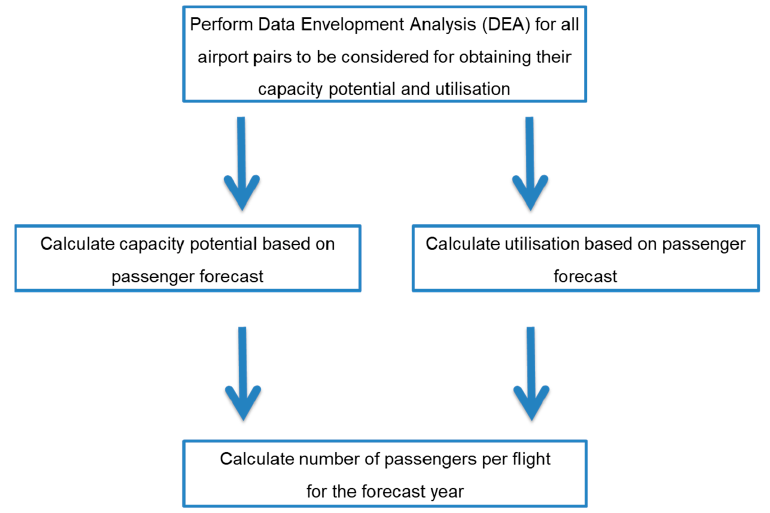
Figure 7. Forecasting the passengers per aircraft for each airport pair.